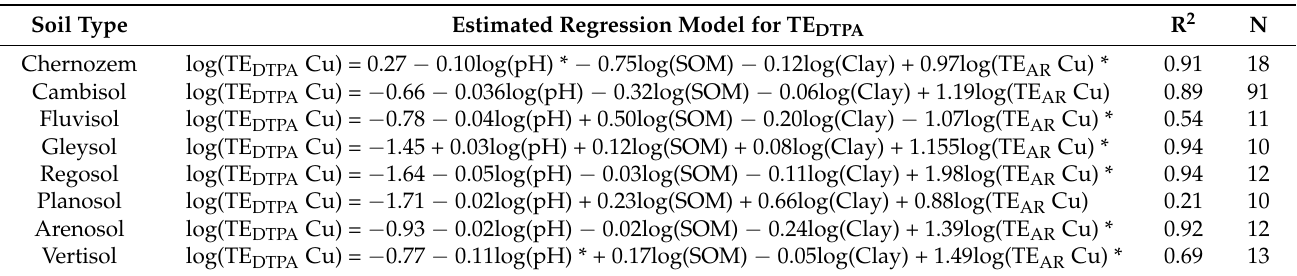
Table 15. Prediction model